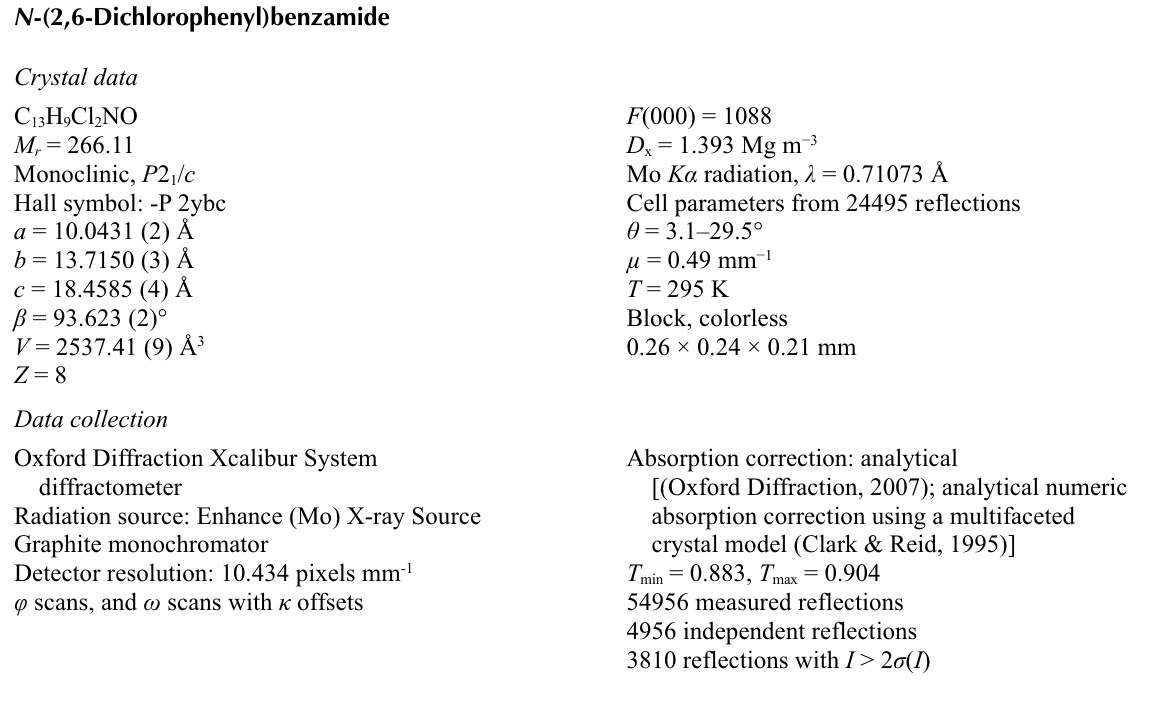
Crystal structure of the title compound viewed down the b axis. One-dimensional chains along the base vector [1 0 0] are formed by hydrogen bonds N1–H1N···O2 and N2–H2N···O1(i). Symmetry code (i): x + 1, y , z . H atoms not involved in hydrogen bonding are